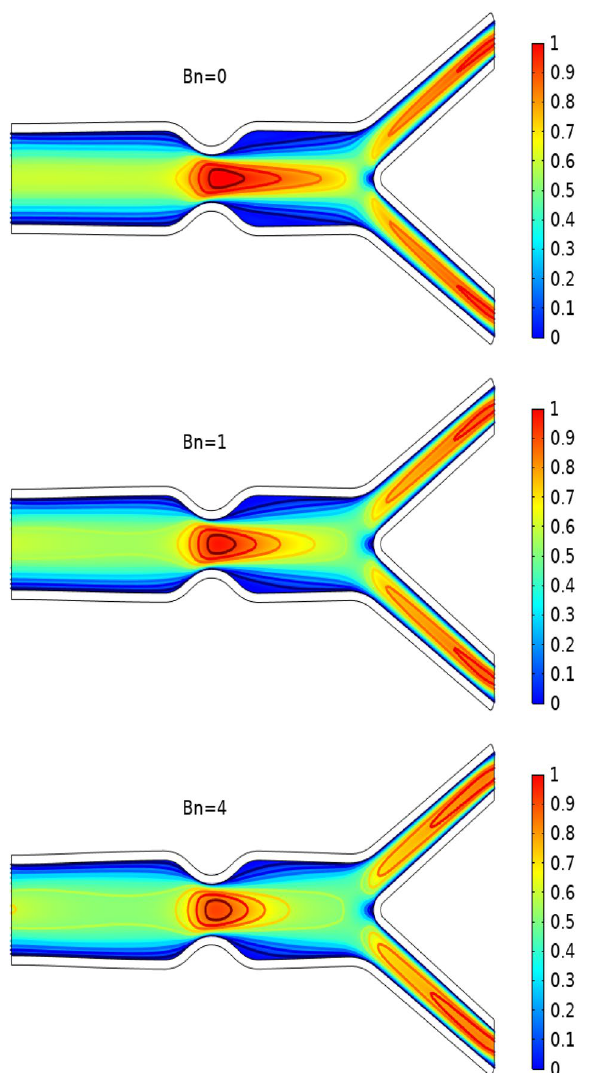
Figure 3. Velocity profile at Re = 200 for variation of